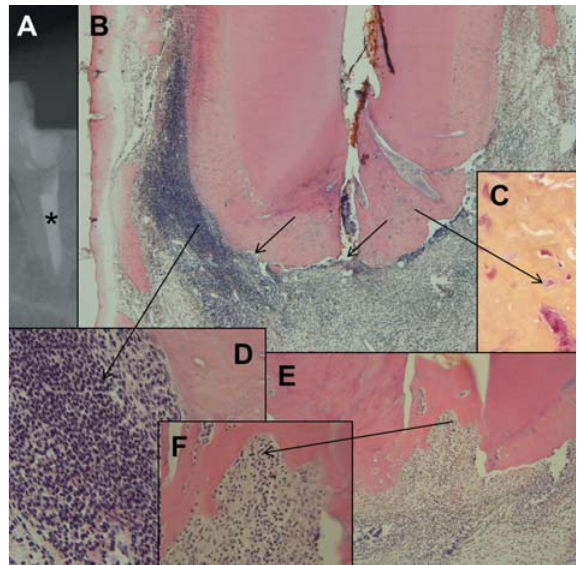
Figure 4- Representative images of the Endo-CPM- Sealer® group. (A) Radiographic examination (*) 180 (cid:28)(cid:5)(cid:9)(cid:15)(cid:13) (cid:5)(cid:29)(cid:6)(cid:3)(cid:25)(cid:13) (cid:27)(cid:10)(cid:10)(cid:11)(cid:12)/(cid:13) !<(cid:25)(cid:11)/(cid:11)(cid:12)(cid:5)(cid:10)%(cid:13) =(cid:8)(cid:21)(cid:18)(cid:13) (cid:16)>(cid:20)(cid:13) ?(cid:5)(cid:12)(cid:7)(cid:25)(cid:5)(cid:4)(cid:11)C(cid:13) (cid:24)(cid:11)(cid:3)(cid:31)(cid:13) showing areas of resorption and the absence of newly formed cementum (arrows) [×100; hematoxylin & eosin (H.E.)]. (C) Gram-negative microorganisms in cementum lacunae (arrows) [×400; Brown and Brenn (B.B.)]. (D) (cid:23)(cid:3)(cid:24)(cid:3)(cid:25)(cid:3)(cid:13) (cid:11)(cid:12)(cid:26)(cid:5)(cid:4)(cid:4)(cid:5)(cid:6)(cid:7)(cid:25)(cid:9)(cid:13) (cid:11)(cid:12)(cid:27)(cid:10)(cid:6)(cid:25)(cid:5)(cid:6)(cid:3)(cid:13) (cid:16)(cid:5)(cid:25)(cid:25)(cid:7)(cid:31)(cid:20)(cid:13) !"#$$(cid:13) V(cid:13) (cid:17)(cid:18)(cid:19)(cid:18)(cid:21)(cid:18)(cid:13) (E) Panoramic view [×100 - H.E.]. (F) Pulp stump with (cid:4)(cid:7)(cid:28)(cid:3)(cid:25)(cid:5)(cid:6)(cid:3)(cid:13) (cid:11)(cid:12)(cid:26)(cid:5)(cid:4)(cid:4)(cid:5)(cid:6)(cid:7)(cid:25)(cid:9)(cid:13) (cid:11)(cid:12)(cid:27)(cid:10)(cid:6)(cid:25)(cid:5)(cid:6)(cid:3)(cid:13) (cid:5)(cid:12)(cid:28)(cid:13) (cid:4)(cid:11)(cid:12)(cid:3)(cid:25)(cid:5)(cid:10)(cid:11)L(cid:3)(cid:28)(cid:13) (cid:6)(cid:11)(cid:15)(cid:15)K(cid:3)(cid:13) (arrow) [×400;